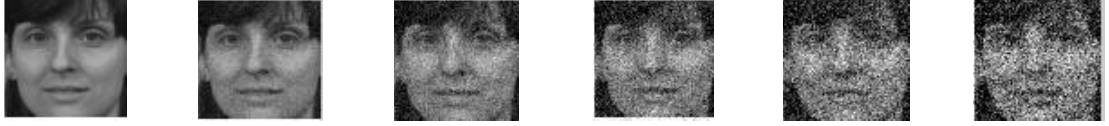
Figure 6. Recognition rate for proposed method in comparison with several other methods.